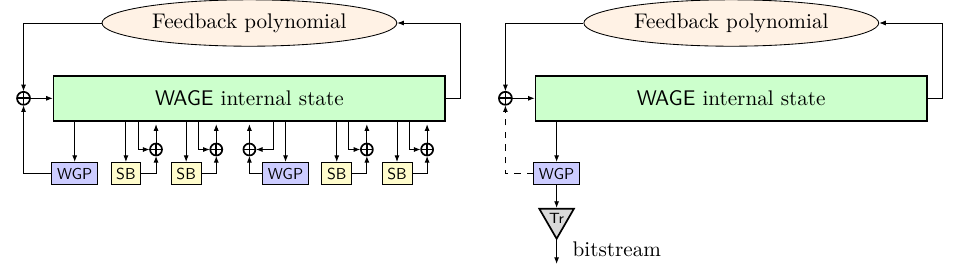
Figure 1: An abstract diagram of WAGE round function (left), and random bit generation feature WG-PRBG (right). Tr denotes the Trace